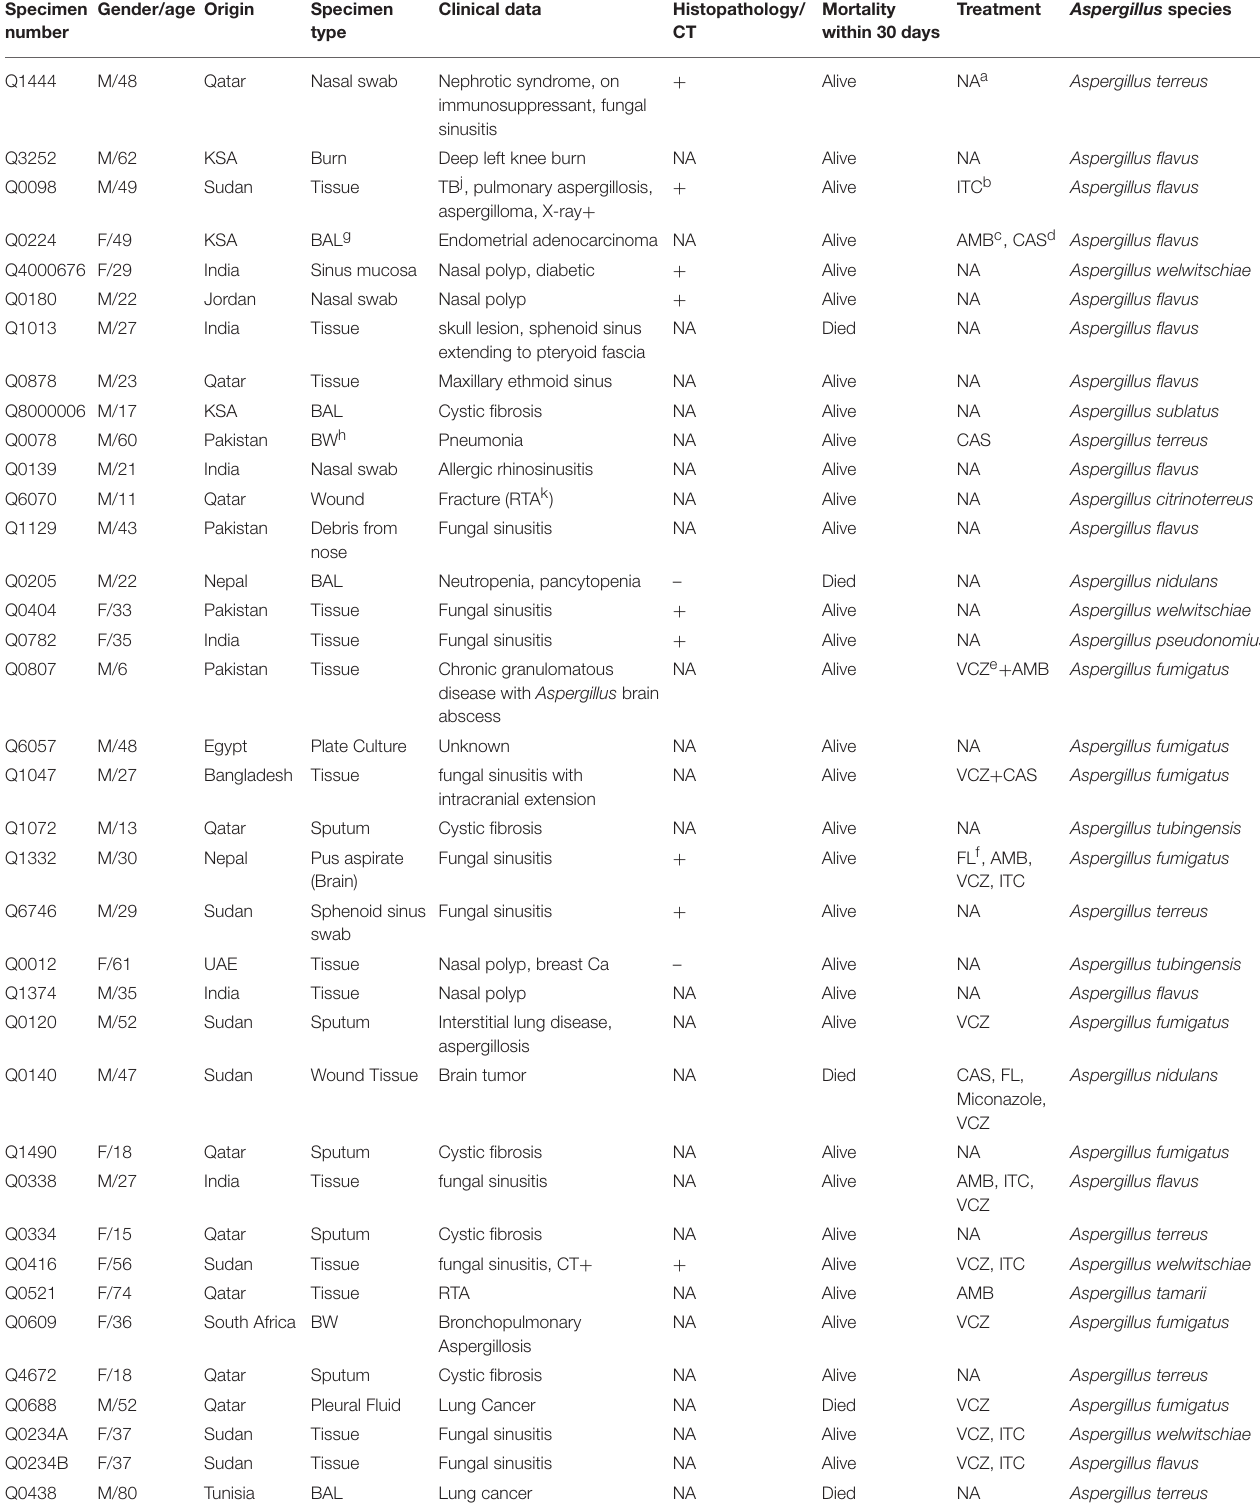
TABLE 1 | Patients demographics, clinical data, antifungal treatment, and Aspergillus spp. isolated. Specimen